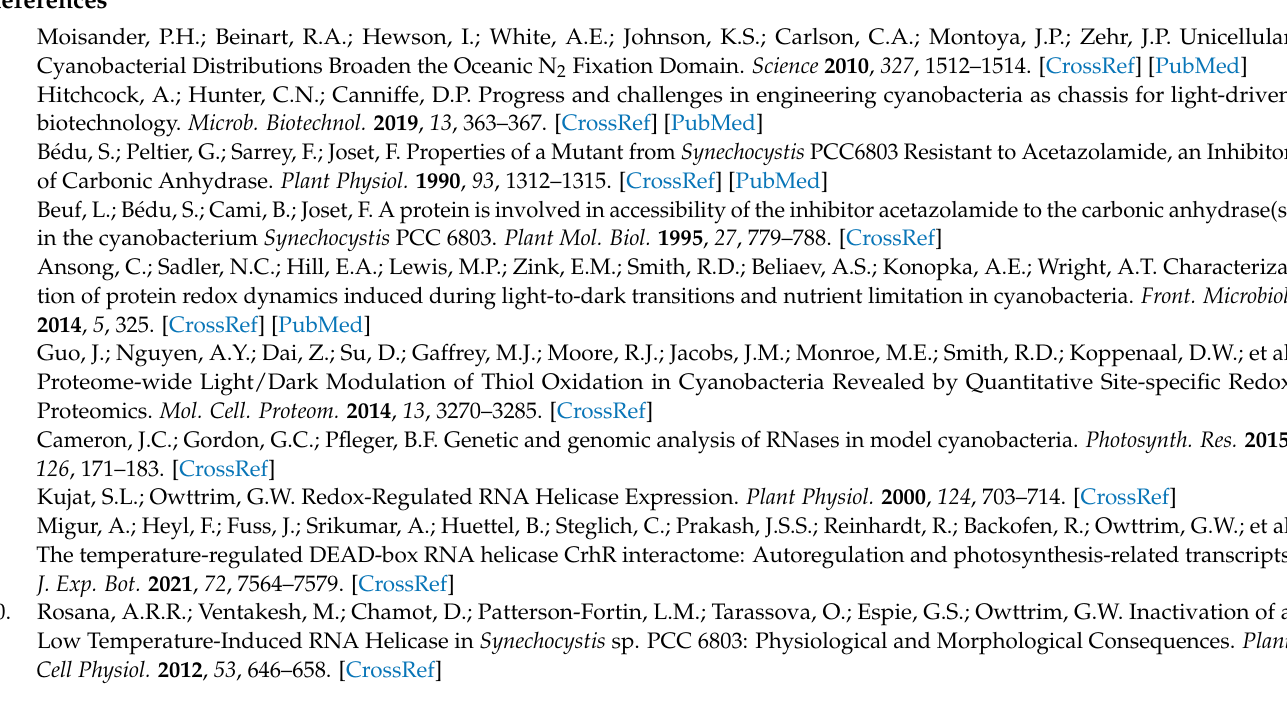
Table S3. Plasmids used in this study; Supplemental Table S4. DNA oligonucleotides used in this study; Supplemental Figure S1. Purification of PCC 7002 Zam from E. coli ; Supplemental Figure S2. Image of ∆ Z and WT-GFP using fluorescence microscopy; Supplemental Figure S3. Growth of WT and ∆ Z in presence of acetazolamide; Supplemental Movie S1. Time-lapse video of ∆ Z and WT-GFP with brightfield and GFP channels; Supplemental Movie S2. Time-lapse video of ∆ Z and WT-GFP with chlorophyll channel; Supplemental Movie S3. Time-lapse video of ∆ Z and WT-GFP with phycobilisome